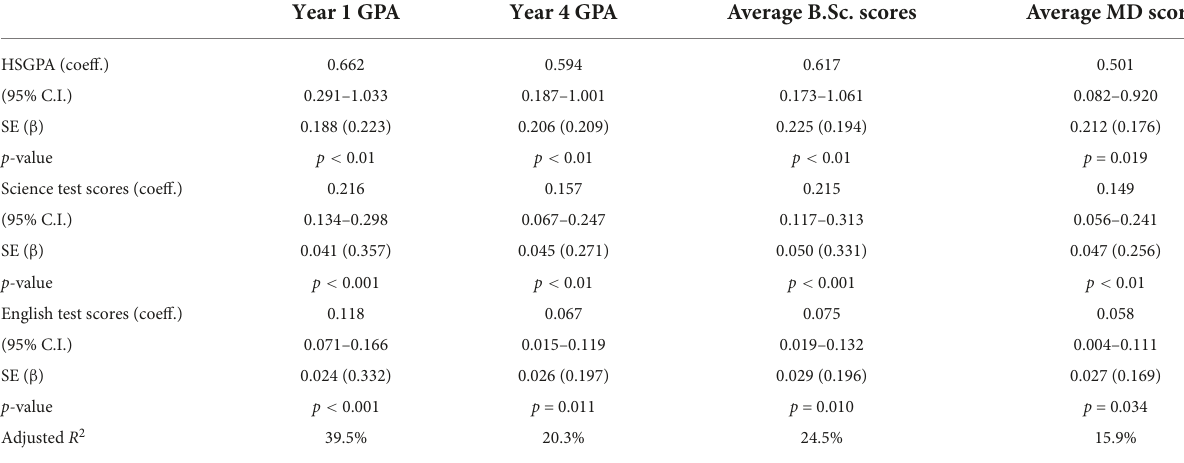
TABLE 4 Regression modeling of the relationship between admission criteria and academic